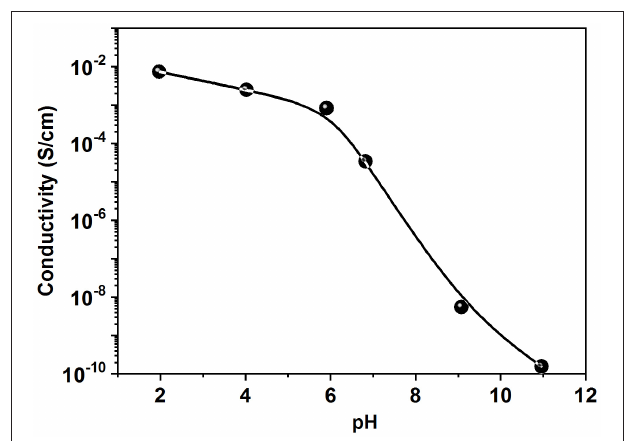
FIGURE 3 | Electrical conductivity of the PANI/Sago blend films at varying